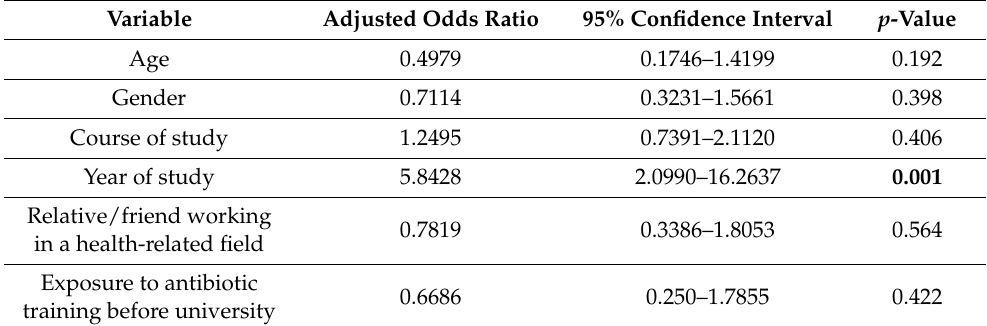
Table 3. Multiple logistic regression between students’ characteristics and their overall